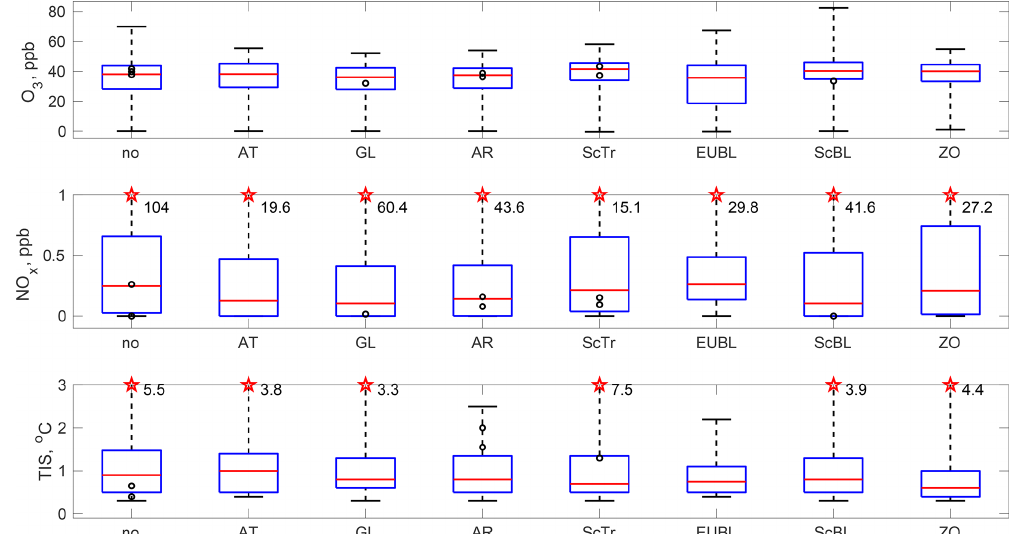
Figure A4. (a) O 3 concentrations for different weather regimes for spring seasons 1990–2018. (b) NO x concentrations for different weather regimes for spring seasons 1990–2018. (c) Temperature inversion strength for different weather regimes for spring seasons 1990–2018. The maximum values that exceed y -axis limits in plots (b) and (c) are shown with red stars.